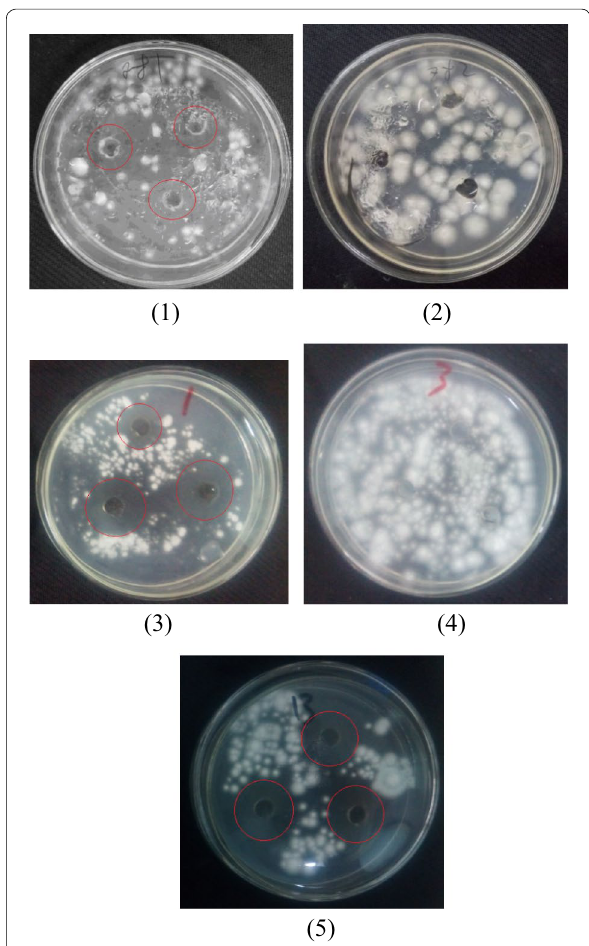
Fig. 2 Antifungal activity of fermentation and aqueous extracts. ( 1 ) Contrast 1 is antifungal test of terbinafine, ( 2 ) contrast 2 is antifungal test of distilled water, ( 3 ) antifungal test of fermentation of puffball, ( 4 ) antifungal test of PDB medium, (retention time from 8 to 12.5 min), ( 5 ) antifungal activity of compound FBR-1 and FBR-2